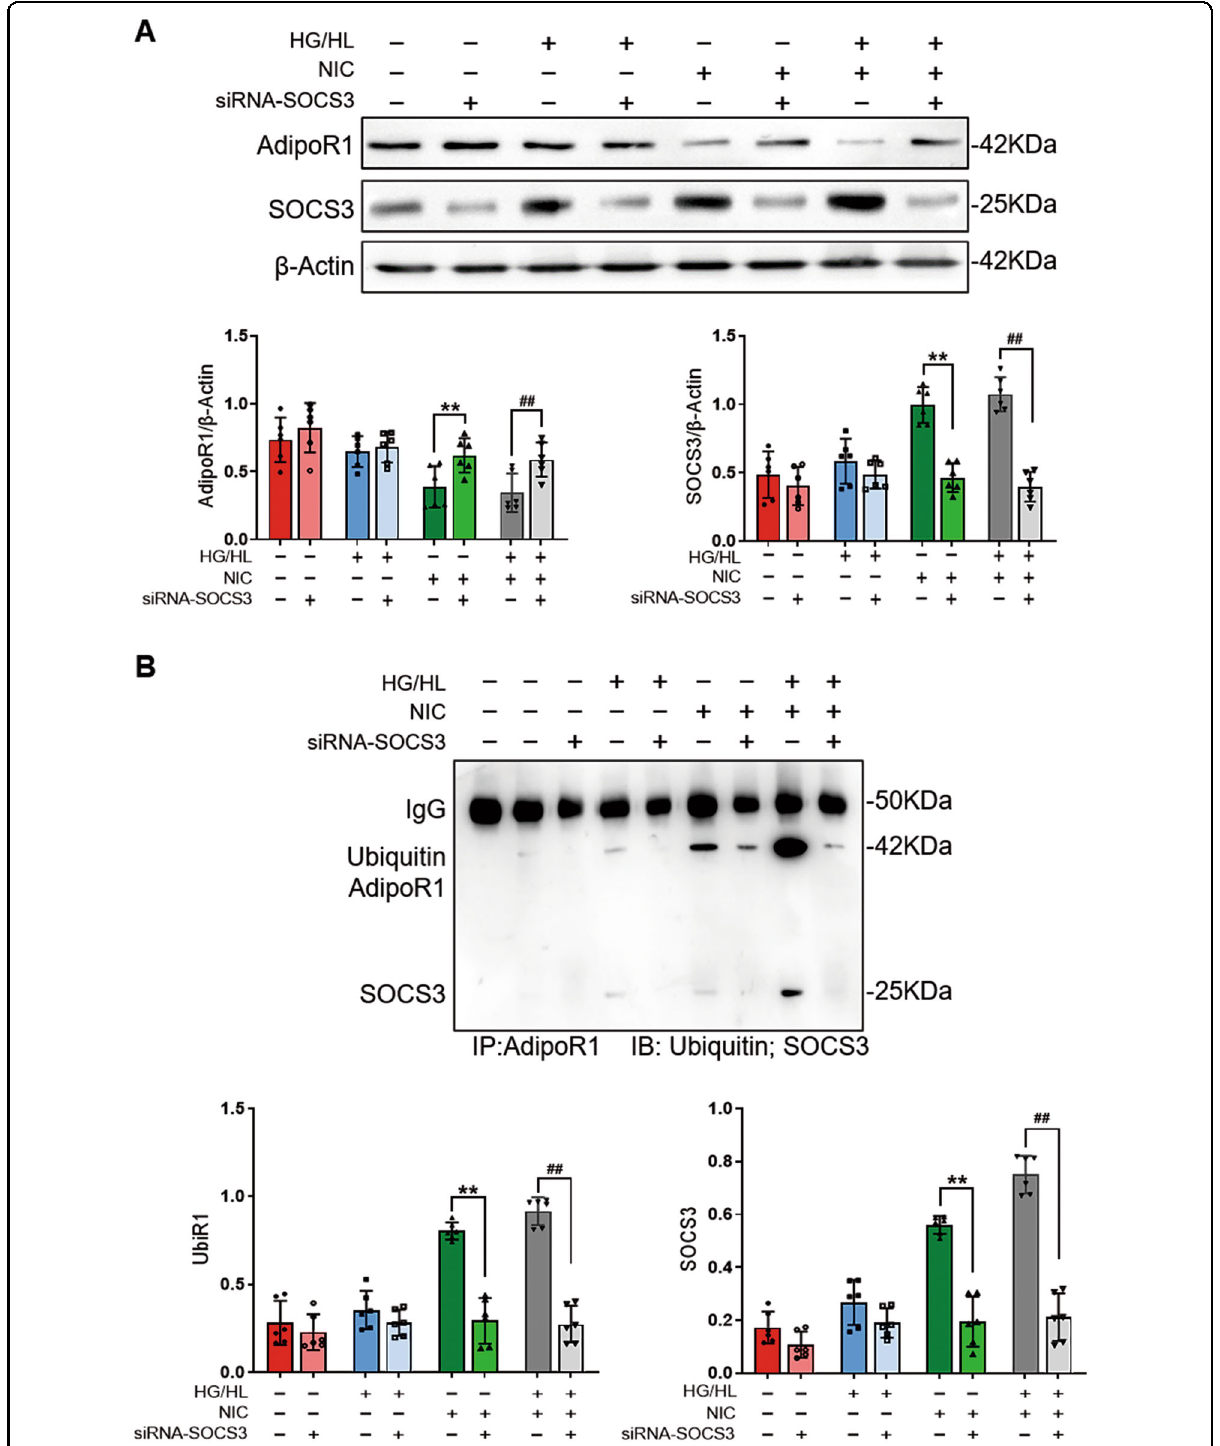
Fig. 5 SOCS3 was required for nicotine-induced AdipoR1 downregulation in diabetes. A SOCS3 de fi ciency restored AdipoR1 level that was suppressed by nicotine or NIC + HG/HL. Top, the western blot showed the protein levels of AdipoR1 and SOCS3. β -Actin as internal references. Bottom, quanti fi cation of the density of western panel. n = 6 dishes/group. ** P <0.01 vs. NIC group; ## P <0.05 vs. NIC + HG/HL group. Data were analyzed by two- way ANOVA. B SOCS3 de fi ciency abolished AdipoR1 ubiquitination induced by nicotine or HG/HL. Top, co-immunoprecipitation showed the protein level of ubiquitinated AdipoR1 and SOCS3. Bottom, quanti fi cation of the density of western panel. n = 6 dishes/group. ** P <0.01 vs. NIC group; ## P <0.05 vs. NIC + HG/HL group. Data were analyzed by two-way ANOVA. NIC, nicotine; HG/HL, high glucose/high lipid; UbiR1, ubiquitinated